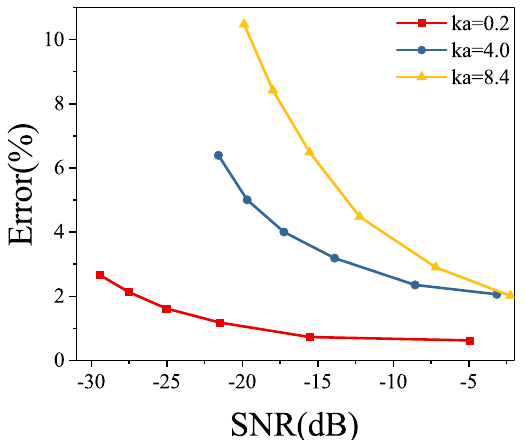
Figure 10. The relative errors of the recovered sound pressure for different frequencies and the